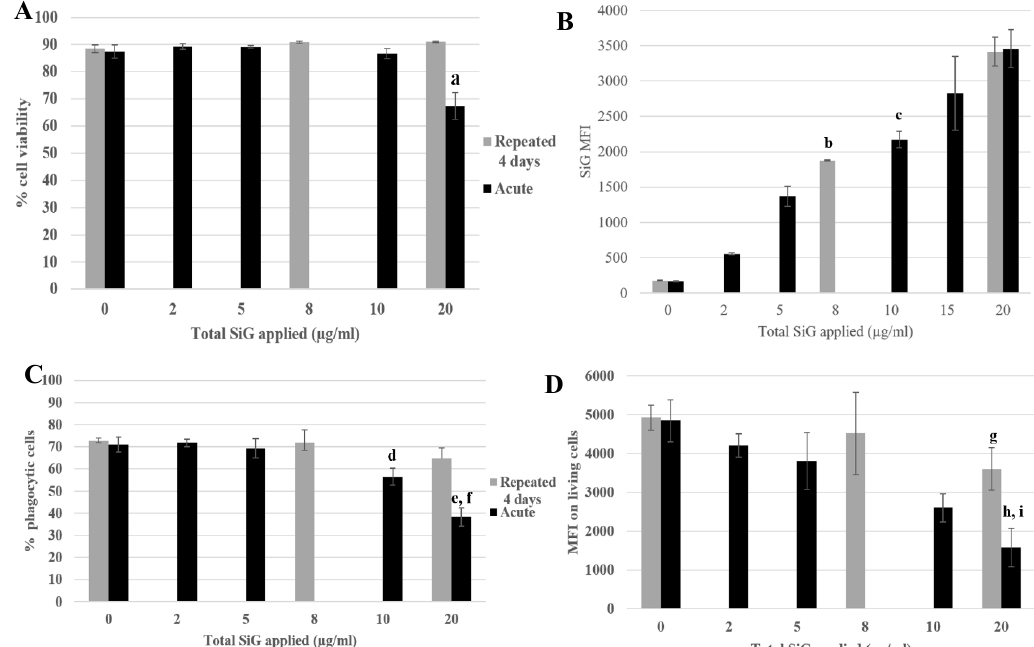
Figure 5. 4-day repeated exposure of RAW264.7 to SiG NP compared with acute exposure. ( A ) Cell viability with propidium iodide. (a: CTL versus acute 20 µg/mL, p -value < 0.01). ( B ) SiG internalization (b: acute 5 µg/mL versus repeated 2 µg/mL, p -value < 0.01; c: acute 10 µg/mL versus repeated 2 µg/mL, p -value < 0.05) . ( C) Proportion of phagocytic cells (d: CTL versus acute 10 µg/mL, p -value < 0,01; e: CTL versus acute 20 µg/mL, p -value < 0.01; f: repeated 5 µg/mL versus acute 20 µg/mL, p value < 0.01) . ( D ) Phagocytosis of the cells. (g: CTL versus repeated 5 µg/mL, p -value < 0,05; h: CTL versus acute 20 µg/mL, p -value < 0.01; i: repeated 5 µg/mL versus acute 20 µg/mL, p value < 0.05).